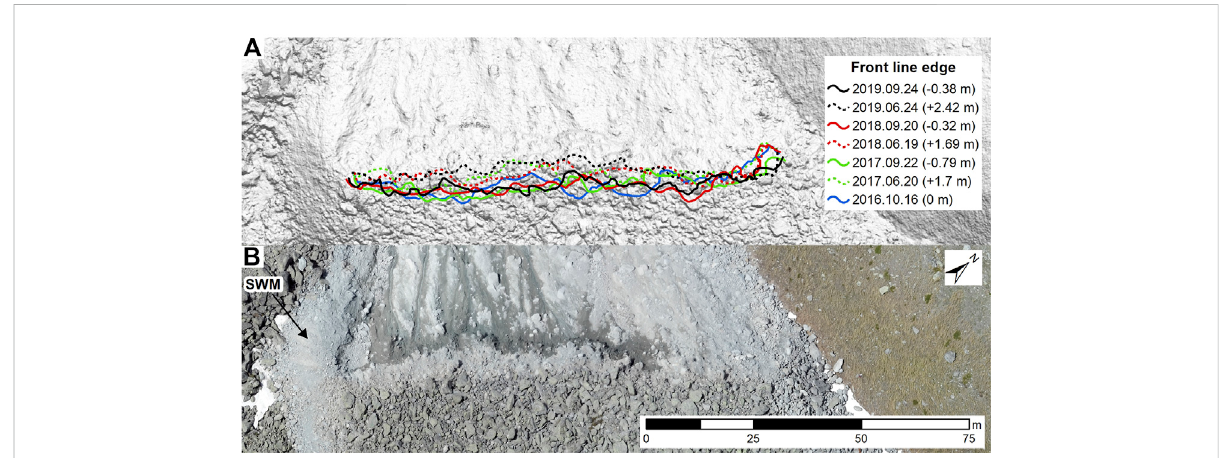
FIGURE 6 (A) Fluctuations of the front line edge between 2016 and 2019 based on the analysis of the respective orthomosaics. Dashed and continuous lines represent late spring/early summer and late summer/early autumn frontal rock glacier positions, respectively. The mean front line displacements (calculated over the entire line) relative to the 2016 position are indicated in parentheses. The background image corresponds to a DEM-derived hillshade from June 2019. (B) As an example, the southwestern margin (SWM) is indicated on the orthomosaic from June